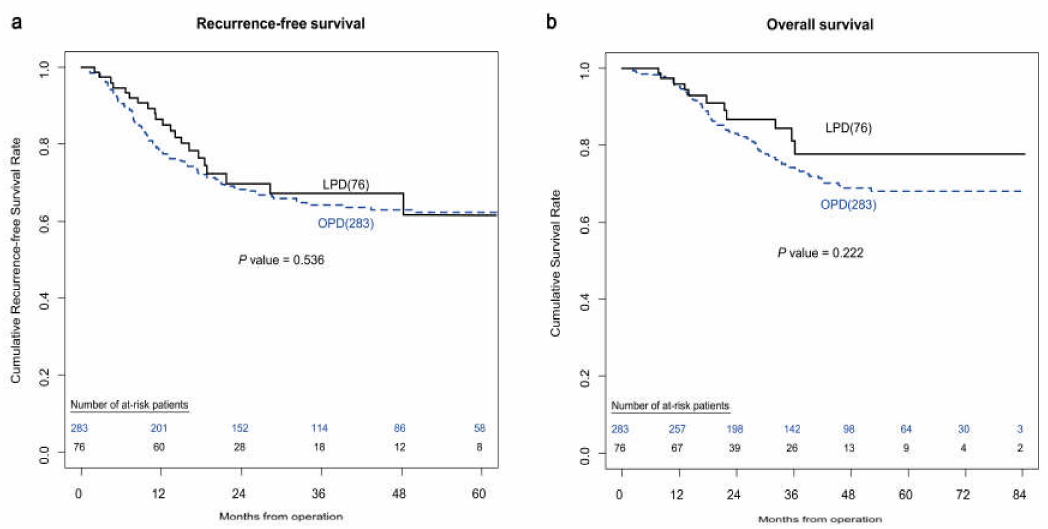
Figure 1. ( a ) Kaplan–Meier curves of recurrence-free survival after surgery in unmatched patients who underwent OPD or LPD. ( b ) Kaplan–Meier curves of overall survival after surgery in unmatched patients who underwent OPD or